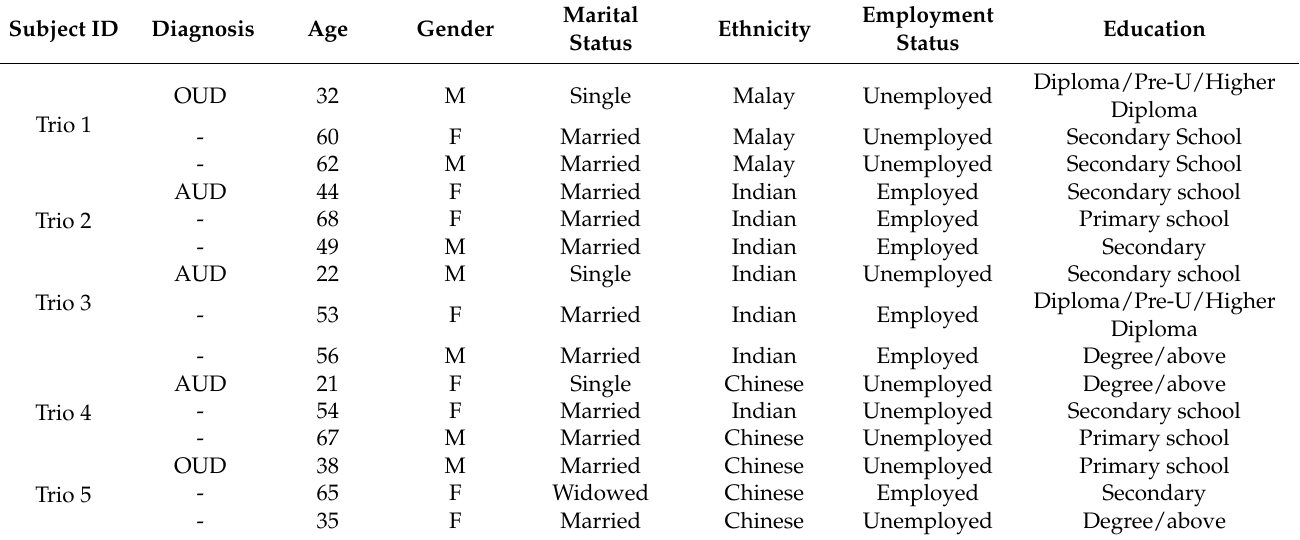
Table 1. Socio-demographic characteristics of the study participants. The formal diagnosis was performed only for the subjects.